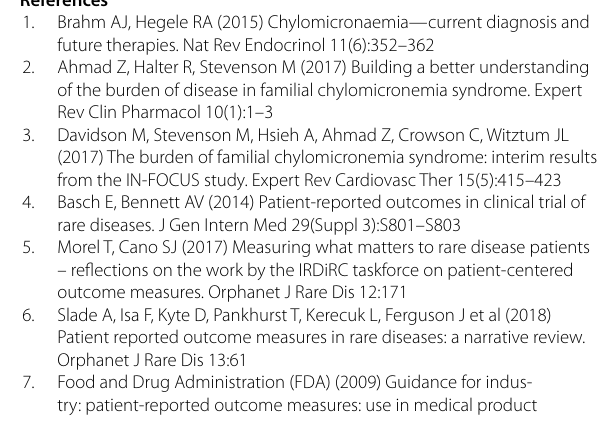
Abbreviations FCS: Familial chylomicronemia syndrome; FDA: US Food and Drug Administra‑ tion; NRS: Numeric rating scale; PRO: Patient‑reported outcome; US: United States; VRS: Verbal response